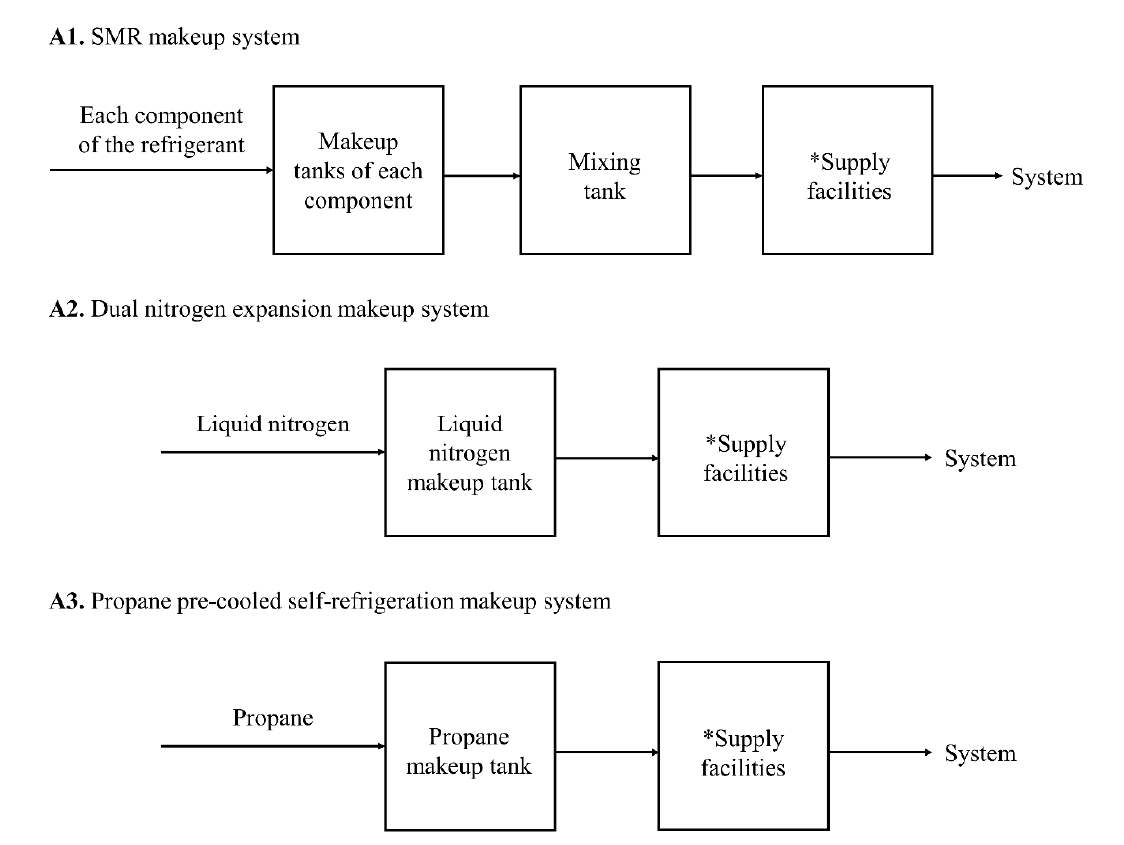
Figure A1. Refrigerant makeup systems for all processes; * The supply facilities consist of pumps and heaters.